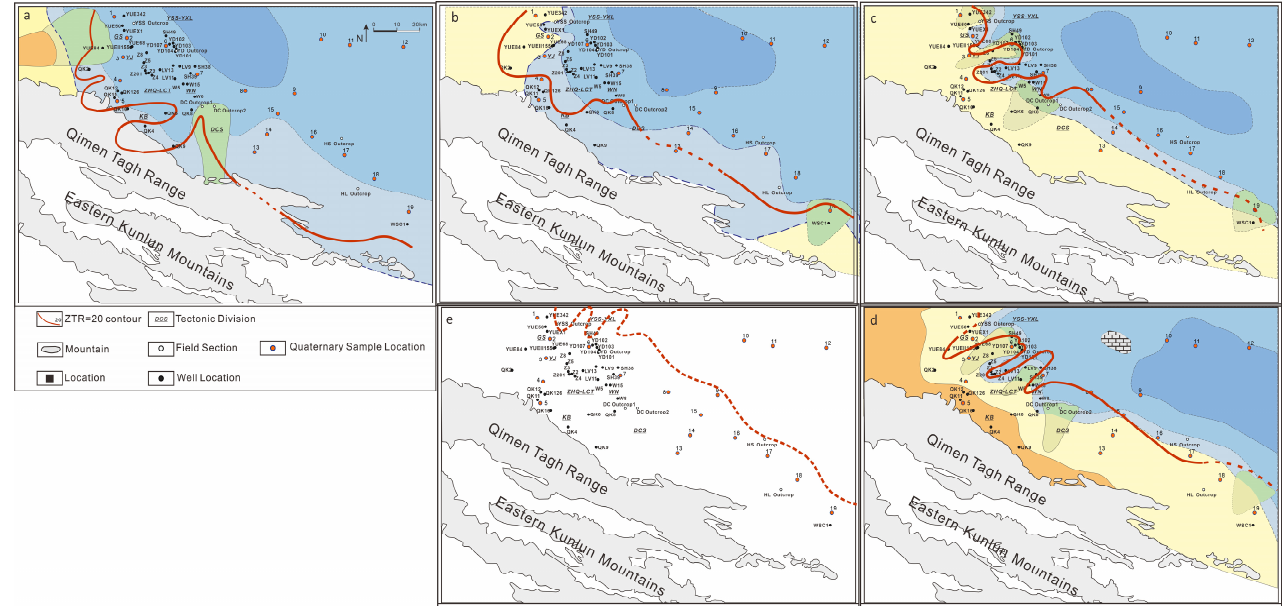
Figure 10. The evolution of sedimentary facies in southwestern Qaidam Basin and ZTR = 20 contour of heavy minerals in each formation. ( a – e ) represent the sedimentary facies of Xia Ganchaigou, Shang Ganchaigou, Xia Youshashan, and Shang Youshashan Formation, respectively. Note that the position of the mountain in the picture is the location of the present Qimen Tagh Range and Eastern Kunlun Mountains. Note that clear sampling location refer to Figure 1b.